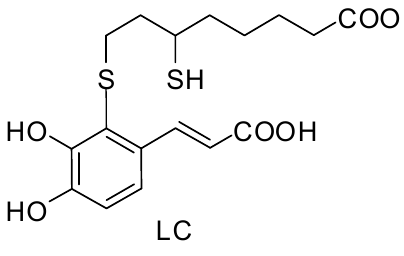
Figure 1. Structure of 2 ‐ S ‐ lipoylcaffeic acid (LC).